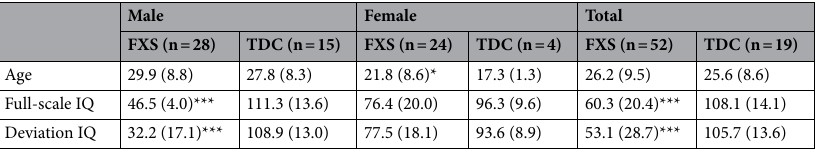
Table 2. Sub-set of participants with FXS included in IQ correlation analysis. FXS Fragile X Syndrome, TDC Typically Developing Controls, *Indicates p < 0.05, ***Indicates p <